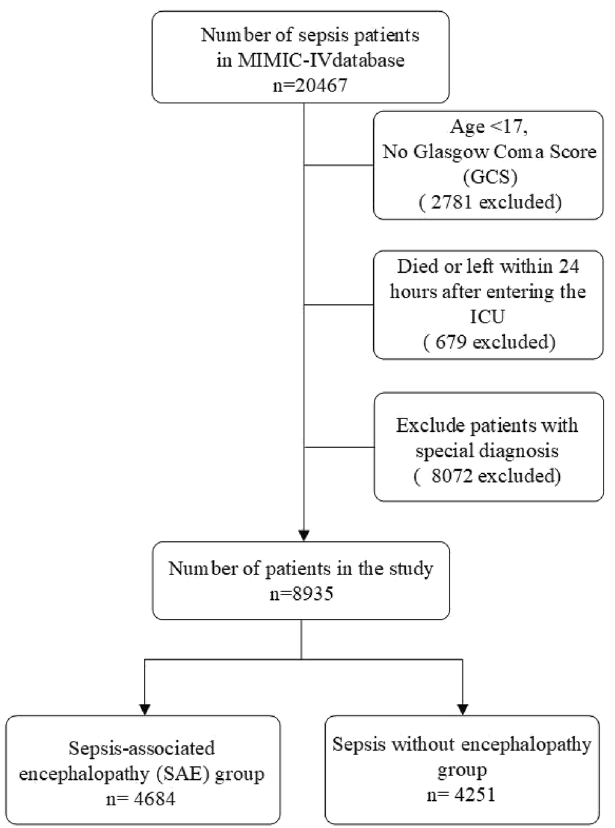
Figure 1. Flow chart of the study population enrollment. The special diagnostics include primary brain injury (traumatic brain injury, ischemic stroke, hemorrhagic stroke, epilepsy, or intracranial infection), severe burn and trauma, chronic alcohol or drug abuse, severe electrolyte imbalances, hyponatremia, hyperglycemia, hypoglycemia, with pre-existing liver or kidney failure affecting consciousness, receiving cardiac resuscitation